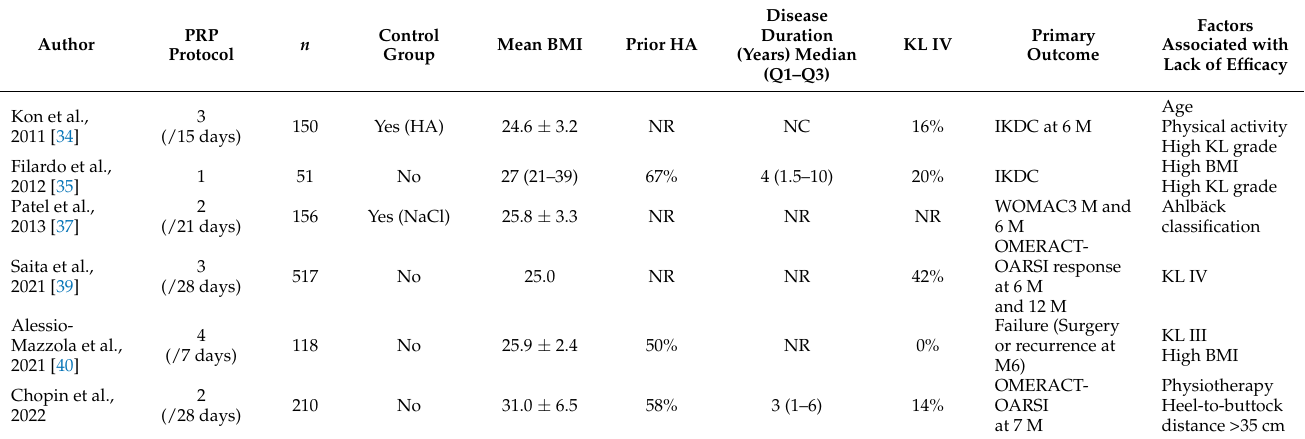
Table 5. Factors associated with response to PRP by multivariable